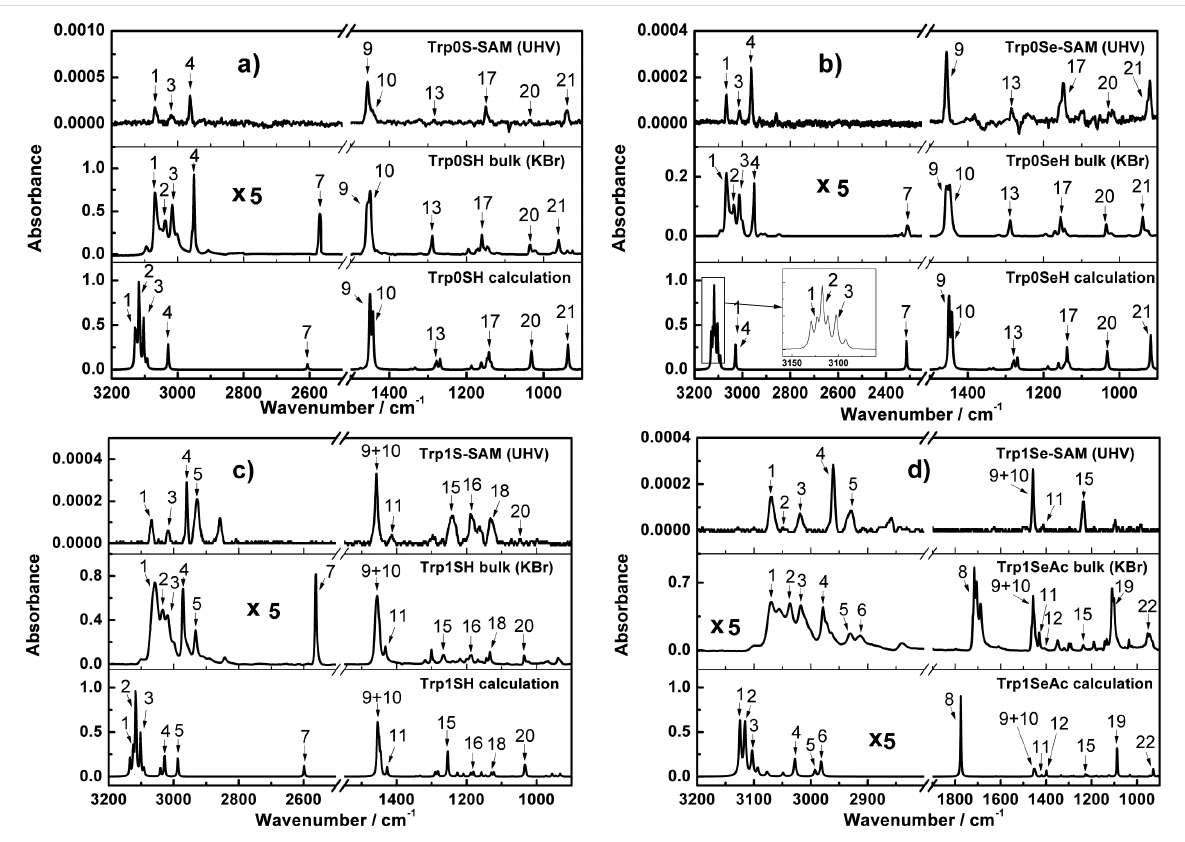
Figure 2: Experimental and calculated spectra of (a) Trp0S-, (b) Trp0Se-, (c) Trp1S-, and (d) Trp1Se-species. In all panels, the upper rows contain the UHV-IRRA spectra of the respective thiolate/selenolate-SAMs on Au(111), the middle rows the KBr pellet spectra and the lower rows the calcu- lated spectra of the isolated molecules displayed in Figure 1. The calculated spectra are given in arbitrary units of